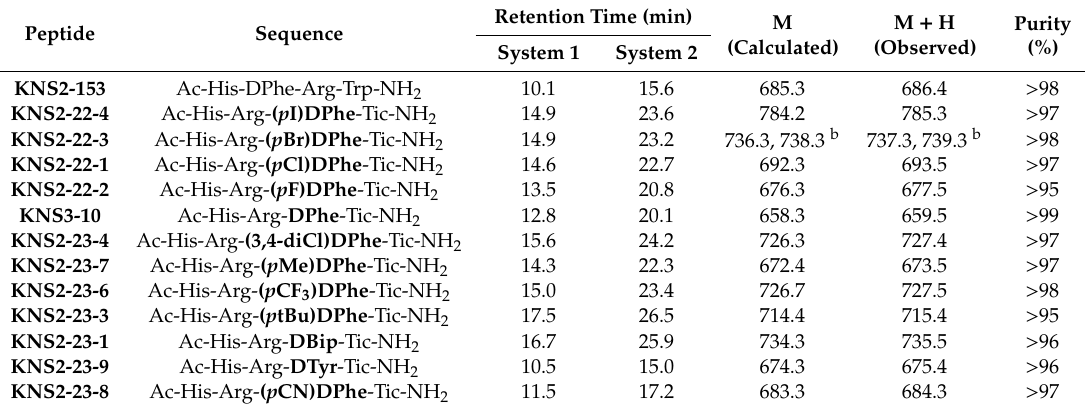
Table 1. Analytical data for peptides synthesized in this study a .